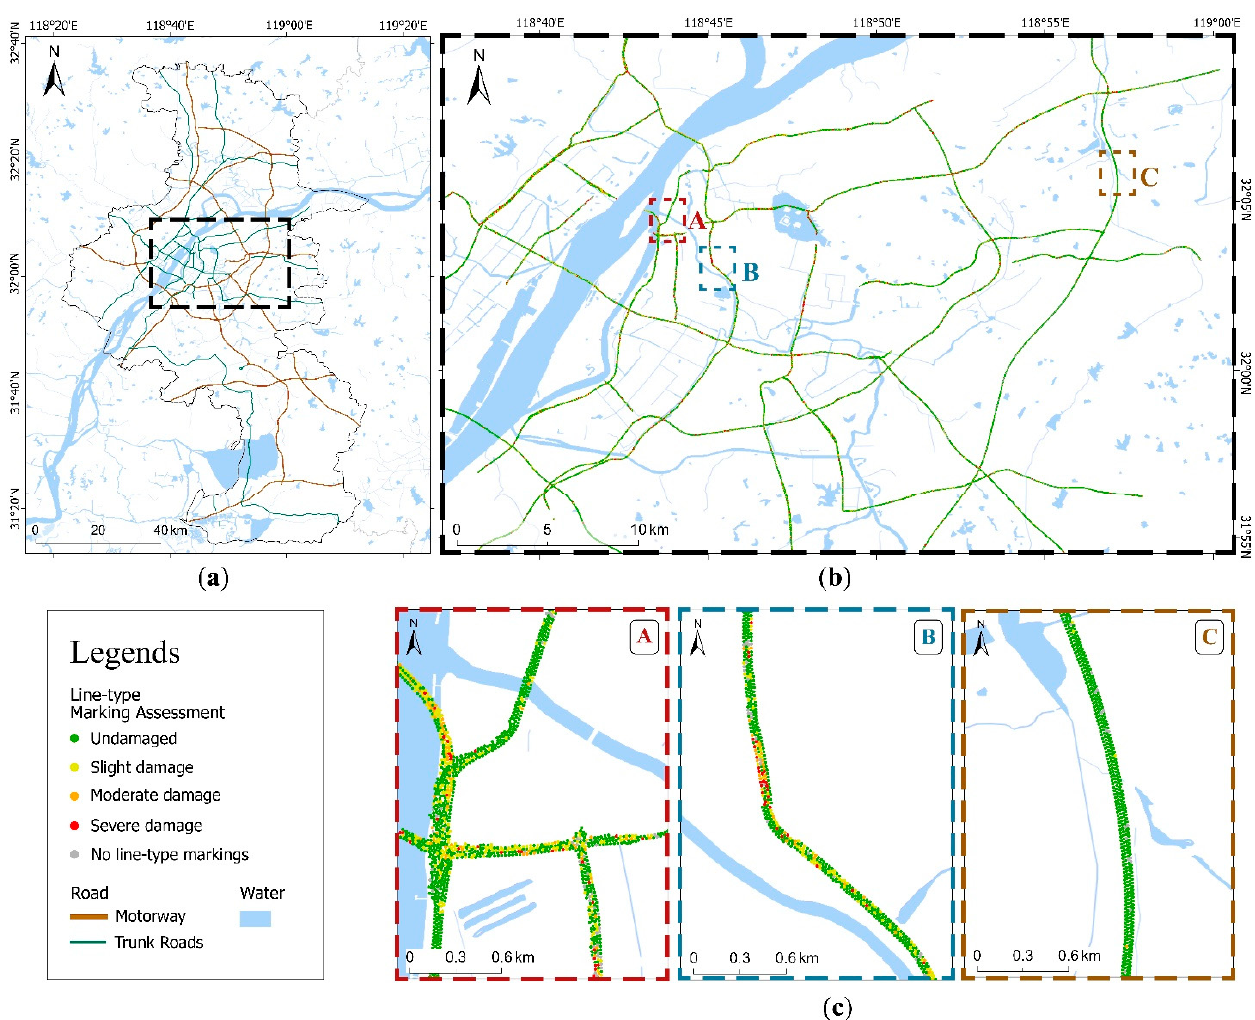
Figure 9. The assessment results for line-type pavement markings of each sampling point in Nanjing. ( a ) Location of detected roads in Nanjing, ( b ) an overview of the assessment results of line-type markings, and ( c ) a detailed display of the marked areas in panel ( b ).